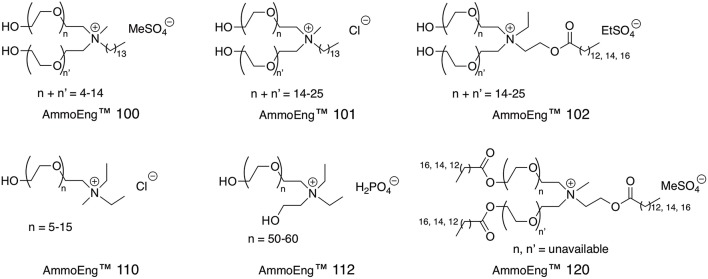
The AmmoEng™ series of ionic liquids.